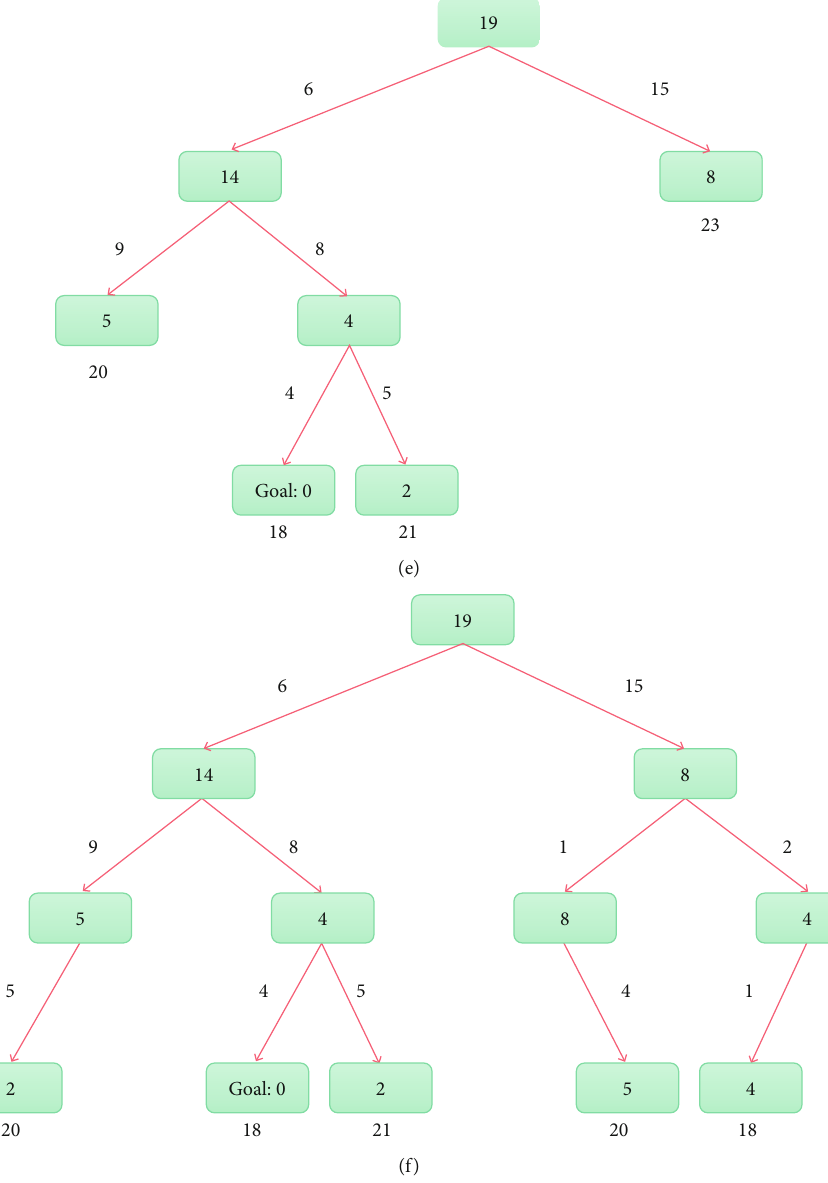
Figure 2: Branch and bound method of low